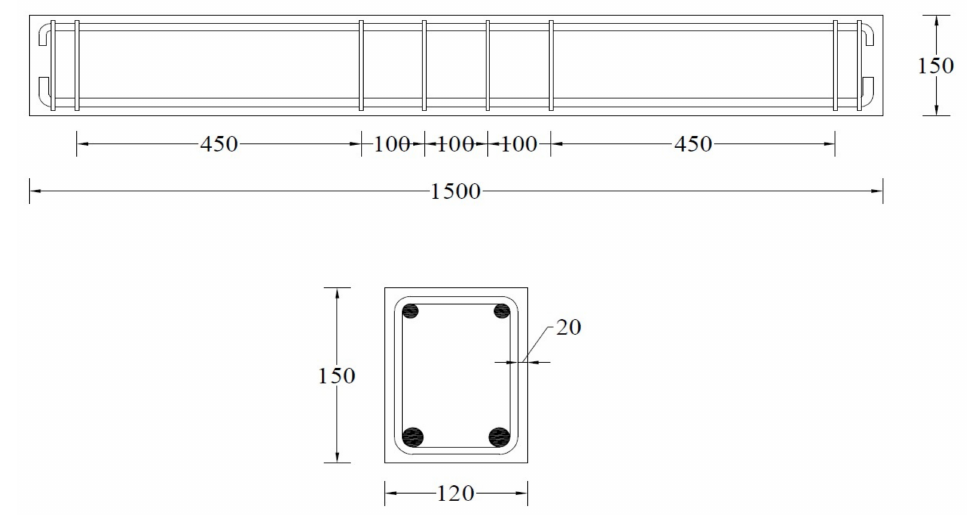
Figure 1. Typical details of RC beams (all dimensions in